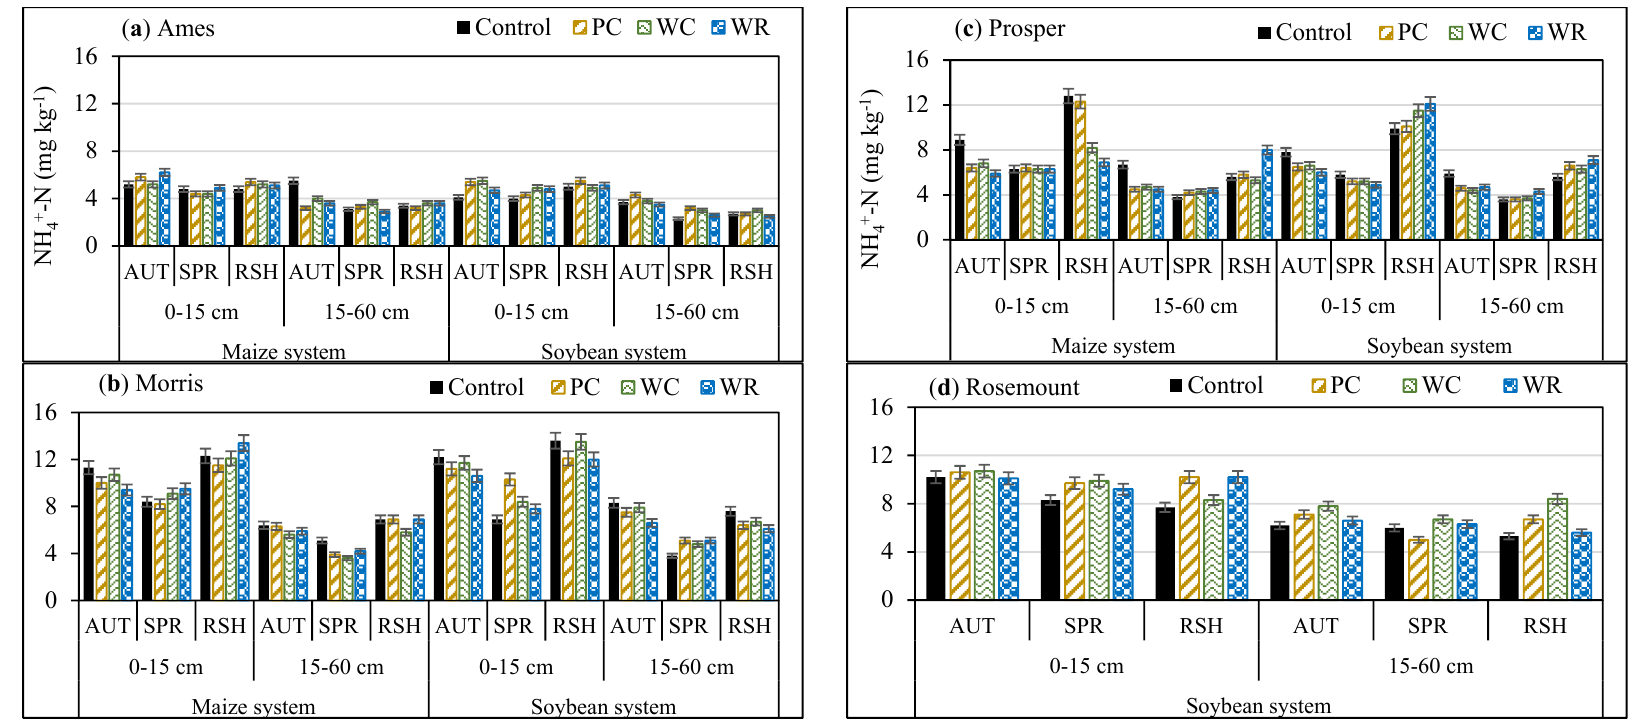
Figure 1. Mean soil NH 4+ -N (mg kg − 1 ) at 0–15 cm and 15–60 cm soil depths for control (no-cover crop), pennycress (PC), winter camelina (WC), and winter rye (WR) when cover crops were interseeded in standing maize and soybean at ( a ) Ames, ( b ) Morris, ( c ) Prosper, and ( d ) Rosemount. Data for Rosemount under maize are not included due to technical error. AUT = soil samples taken in autumn; SPR = soil samples taken in spring; RSH = soil sample taken immediately following relayed soybean harvesting. There was no statistical di ff erence among treatments for same soil depth and same season in a system at a specific location. Error bars are standard error of the means.